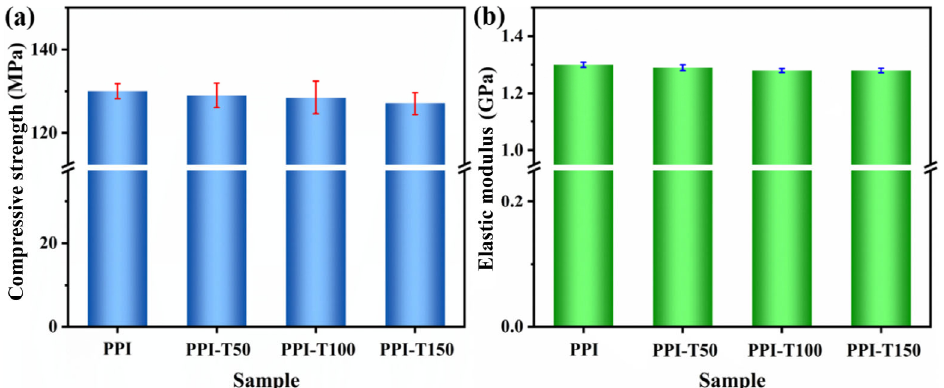
Fig. 5 (a) Compressive strength and (b) elastic modulus of different